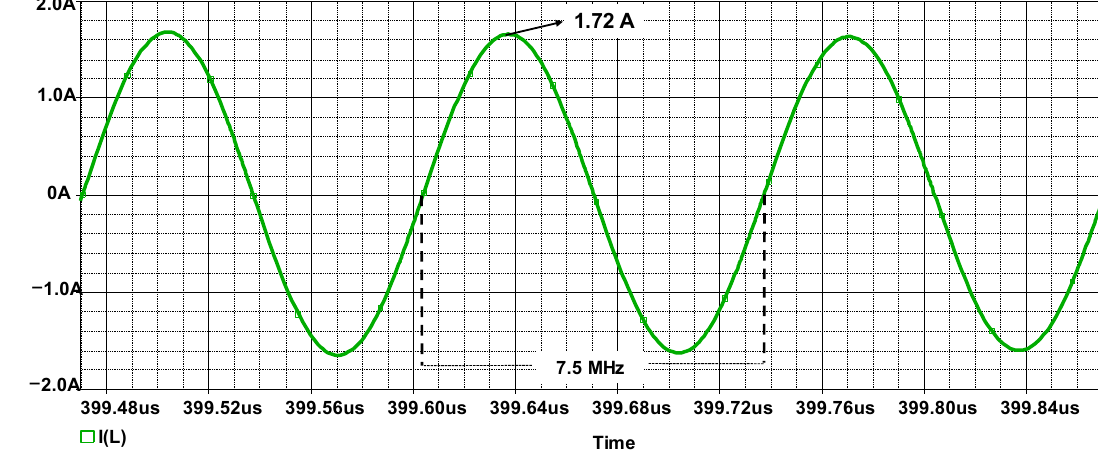
Figure 11. Current in the resonant tank.